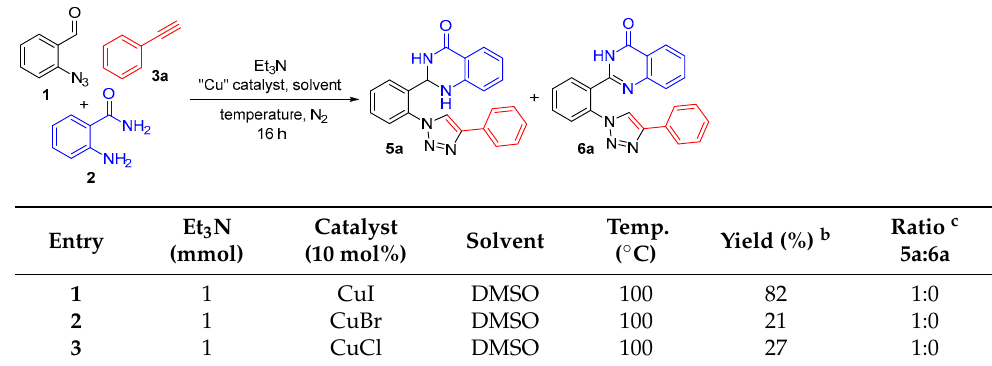
Table 1. Optimization of the reaction conditions. a